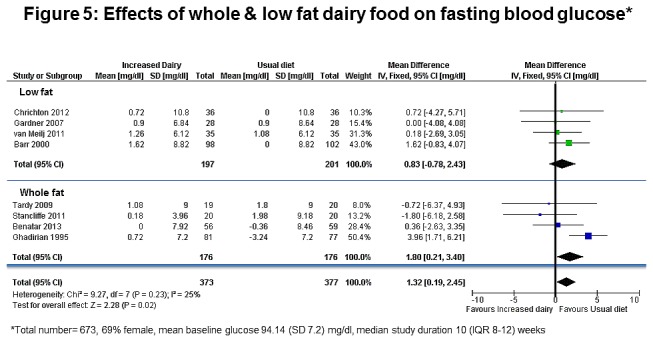
Effects of whole & low fat dairy food on fasting glucose levels.